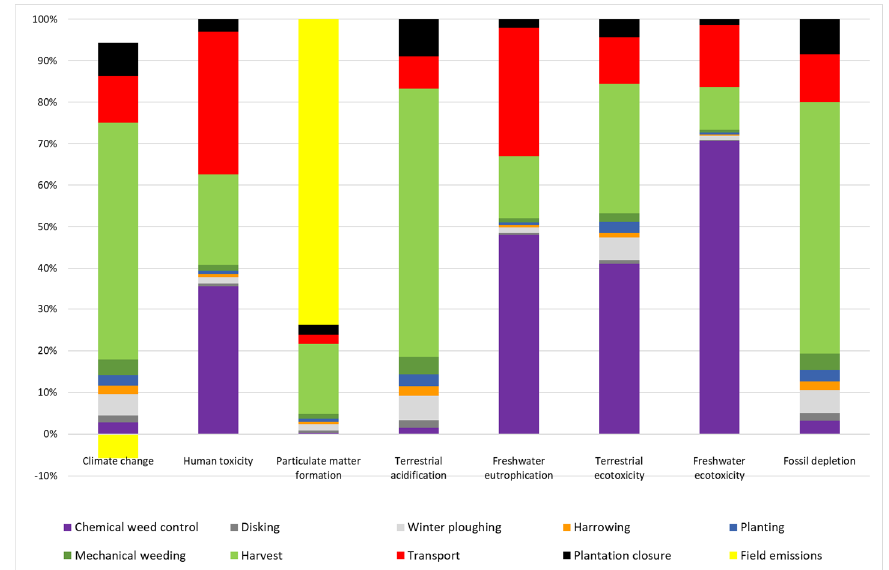
Figure 2. Contribution of miscanthus production processes in selected impact categories in the base scenario (control).